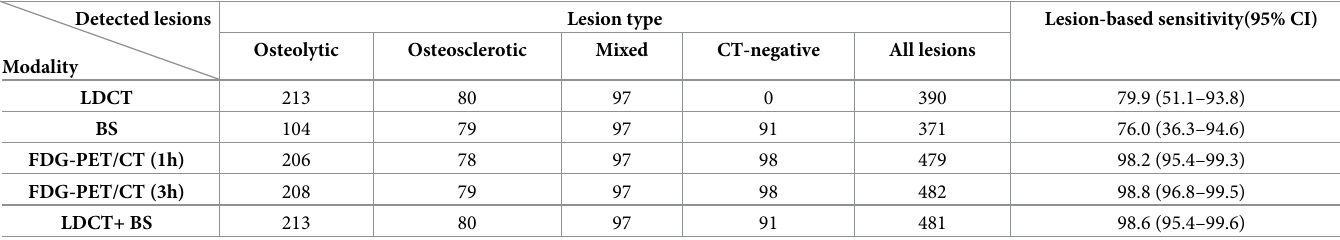
Table 2. Types of detected lesions and lesion-based sensitivity by each